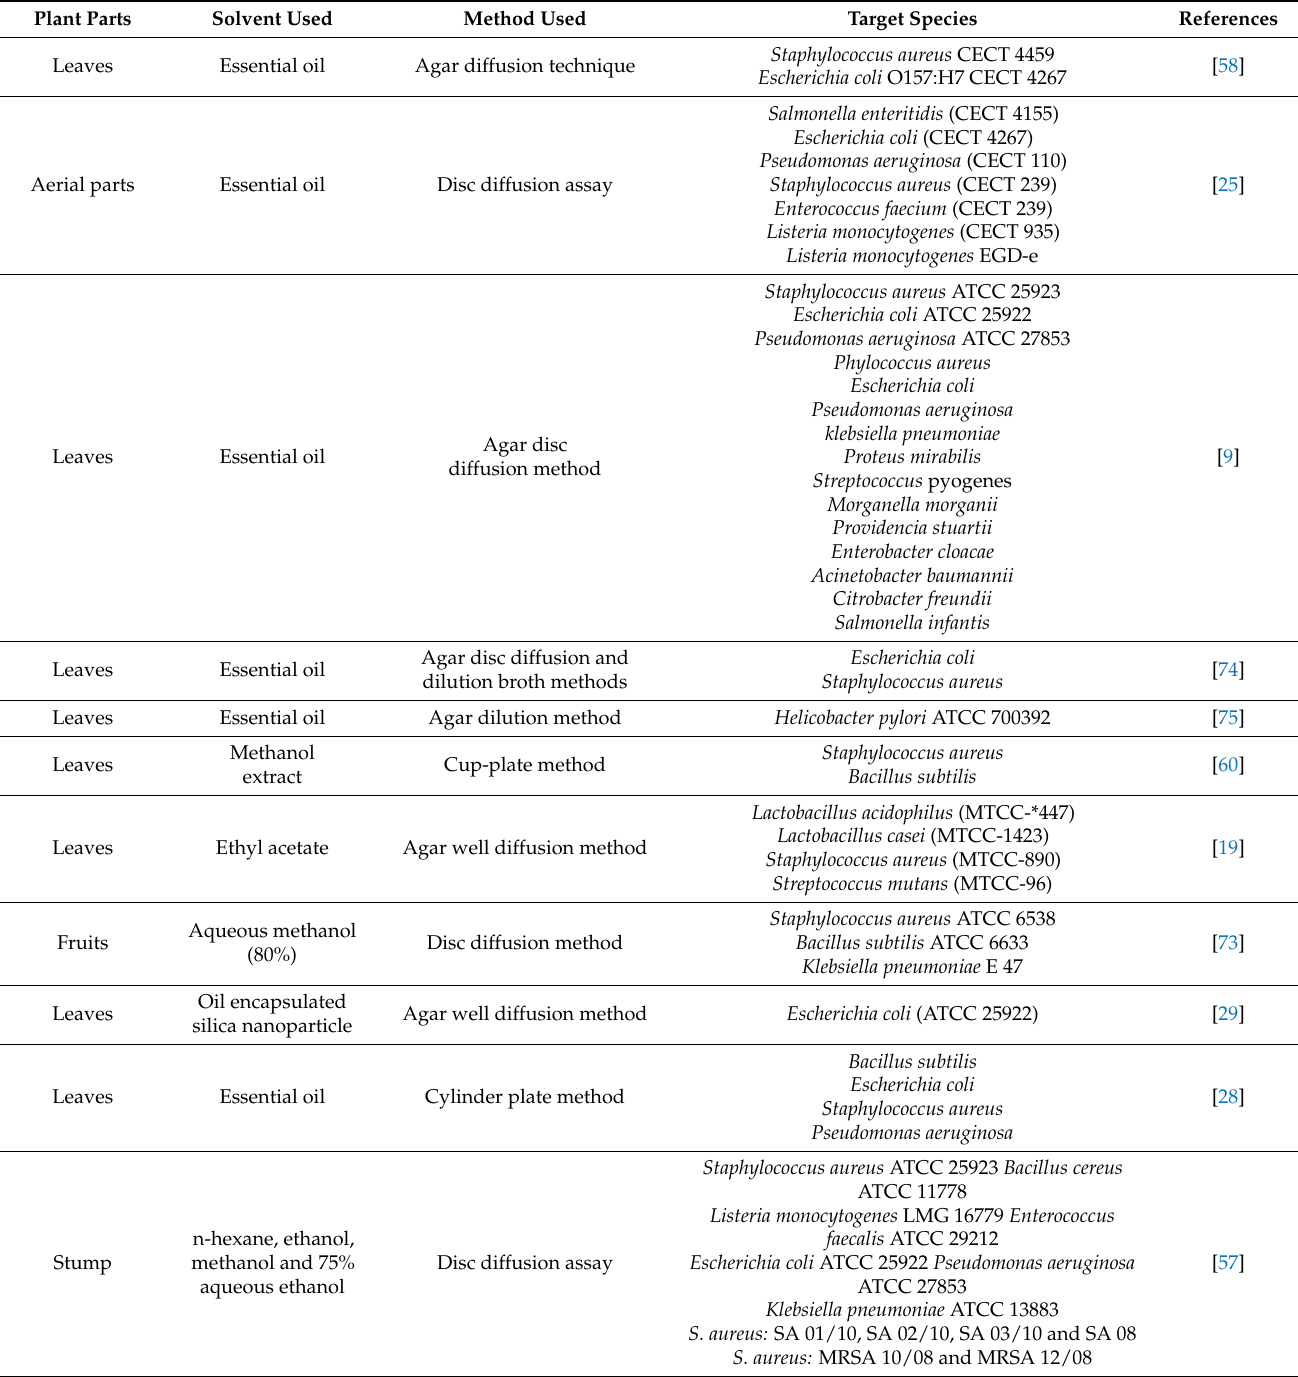
Table 2. Antibacterial activities reported in different parts of E. globulus